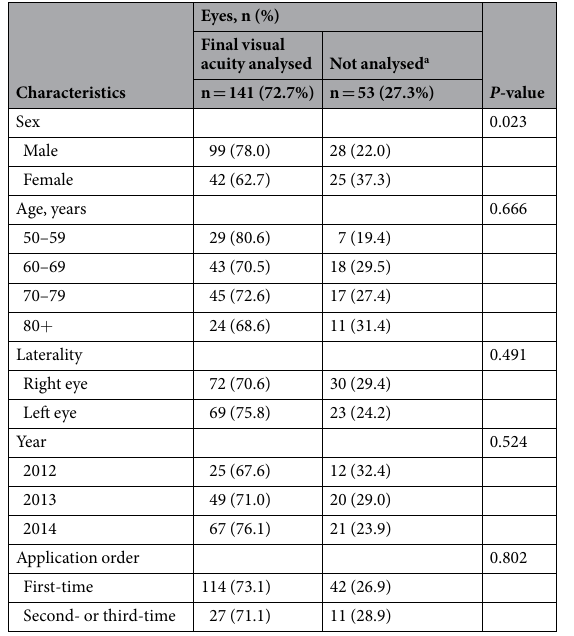
Table 3. Demographics and characteristics of 194 eyes (179 patients) with neovascular age-related macular degeneration treated at a university medical centre in 2012–2014 for which ranibizumab was approved before treatment by the national health insurance system in Taiwan. a Due to missed or inappropriately deferred treatment sessions or to non-recorded final visual acuity.